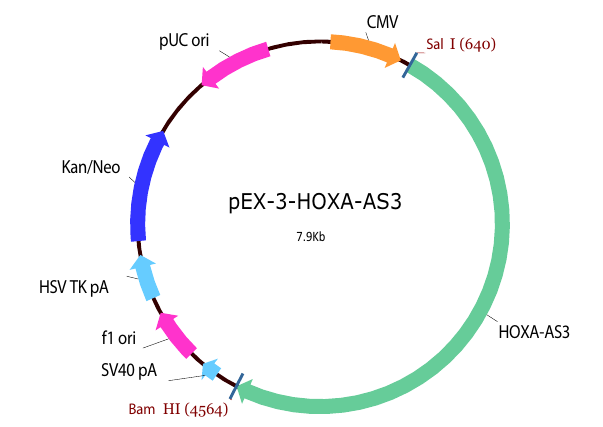
TABLE 1 | Plasmid pro fi le of B3442 PEX-3-HOXA-AS3.